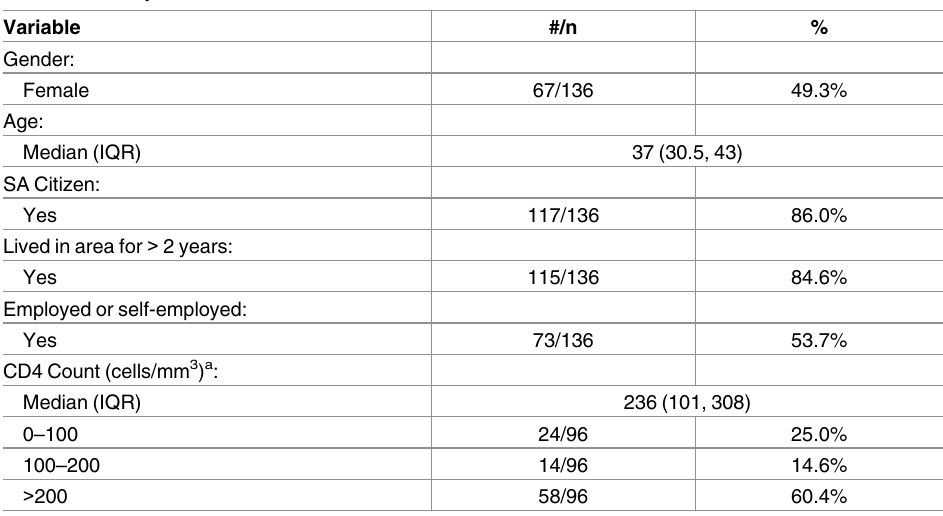
Table 1. Participant characteristics at time of ART